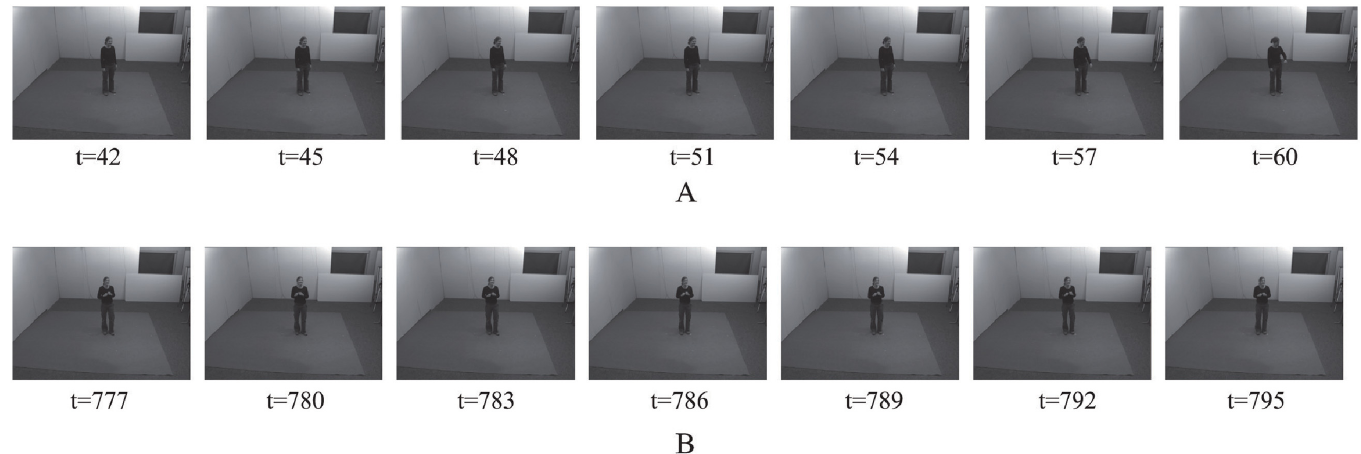
Fig 10. Example of ambiguous-action clips. A: sequence of images from early watch-checking action. B: sequence of ambiguous actions (transition from punching to kicking action).